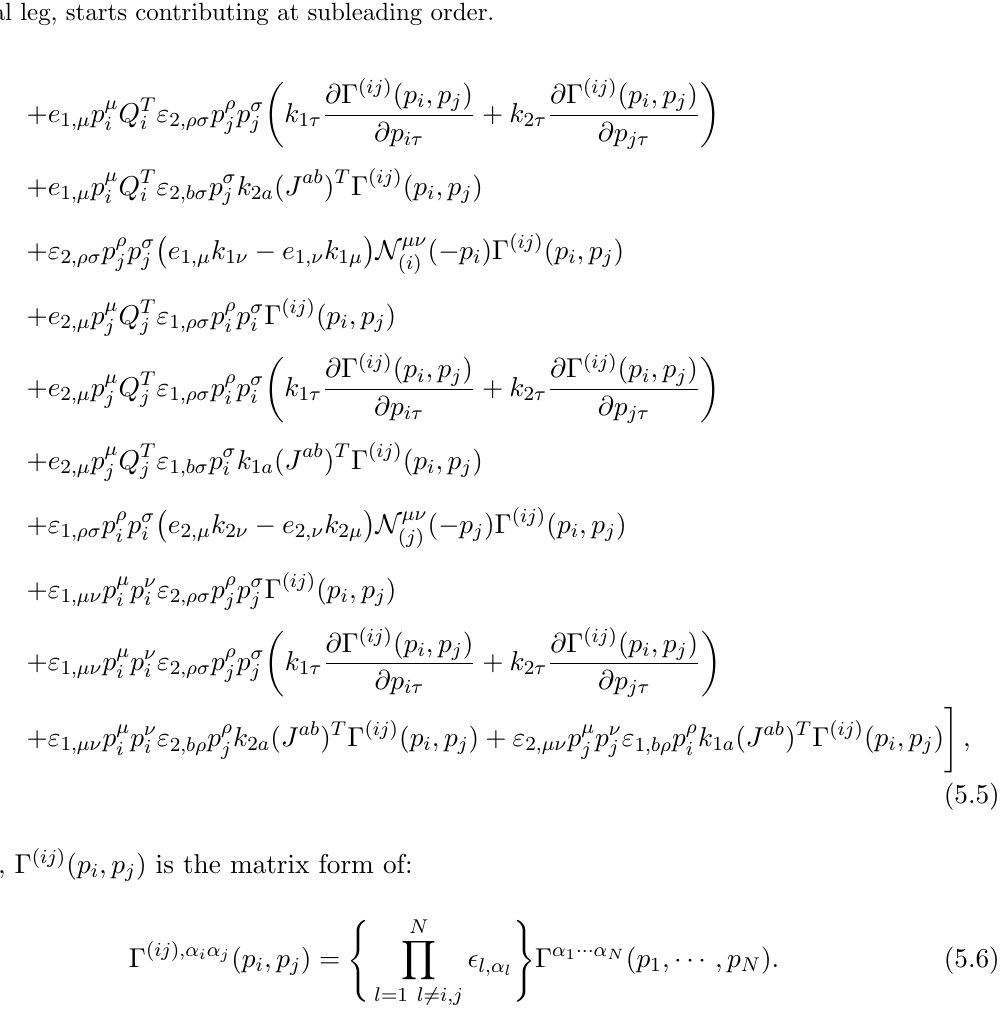
Figure 9 . Diagram with one soft particle attached to external leg and another one attached to internal leg, starts contributing at subleading